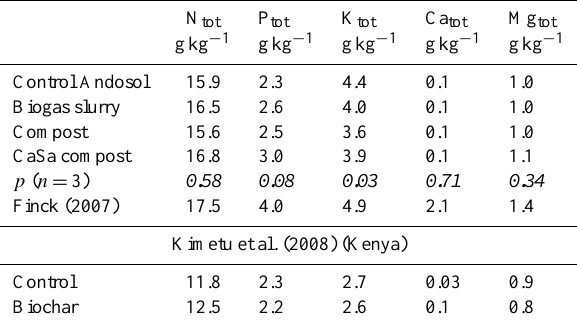
Table 6. Nutrient concentration in dry matter of maize grains com- pared to levels reported in the literature. The italic writing indicates the statistical p values, which belong to the nutrient concentrations in the respective column.